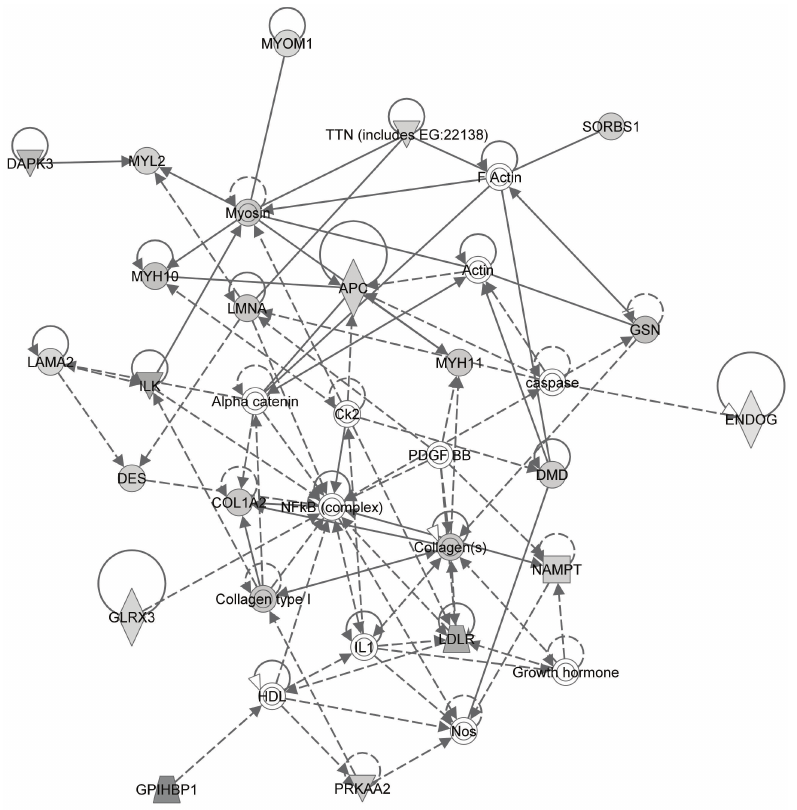
Figure 6: The top network in which the differentially expressed proteins might be involved. The network is for cardiovascular disease, lipid metabolism, and organ development